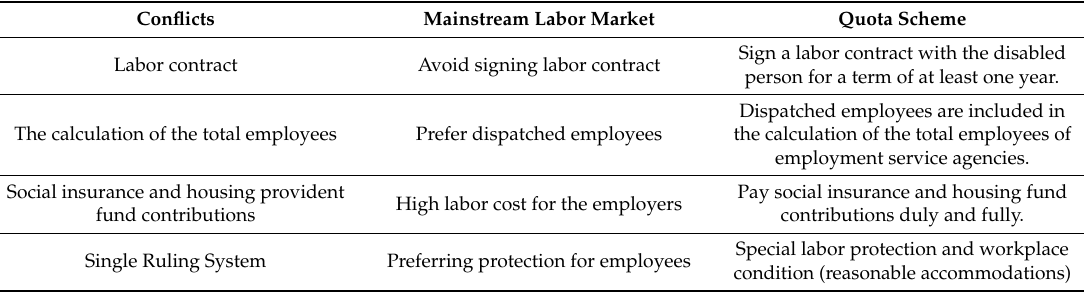
Table 3. The conflicting provisions between mainstream labor market and quota scheme legal frameworks. Conflicts